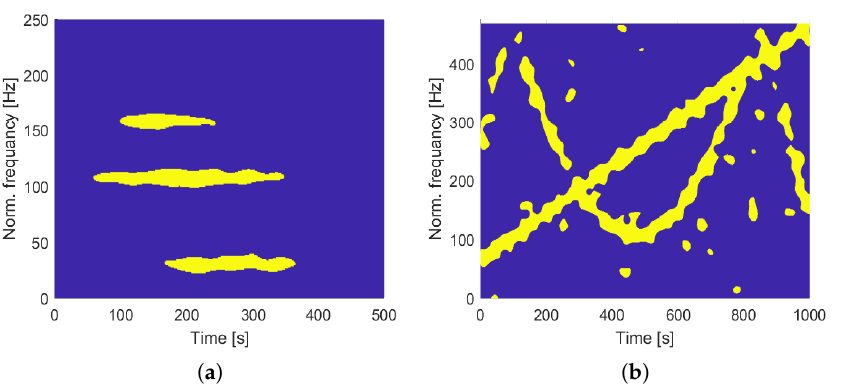
Figure 12. Extracted useful information content obtained by applying the 2DLEM method with the Rényi entropy for SNR = 0 dB. ( a ) Classification mask for the first signal. ( b ) Classification mask for the second